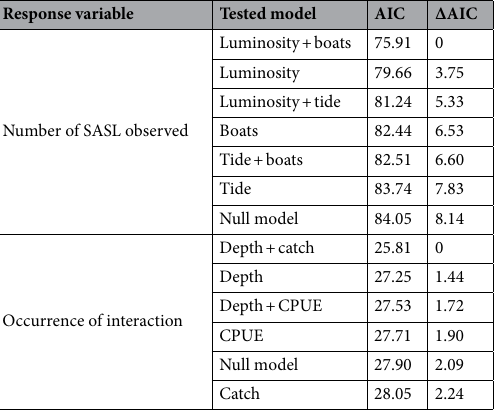
Table 3. Predictive models tested to explain the variation in the number of SASLs observed during the fishing activities and the occurrence of interaction with the fishing tasks.